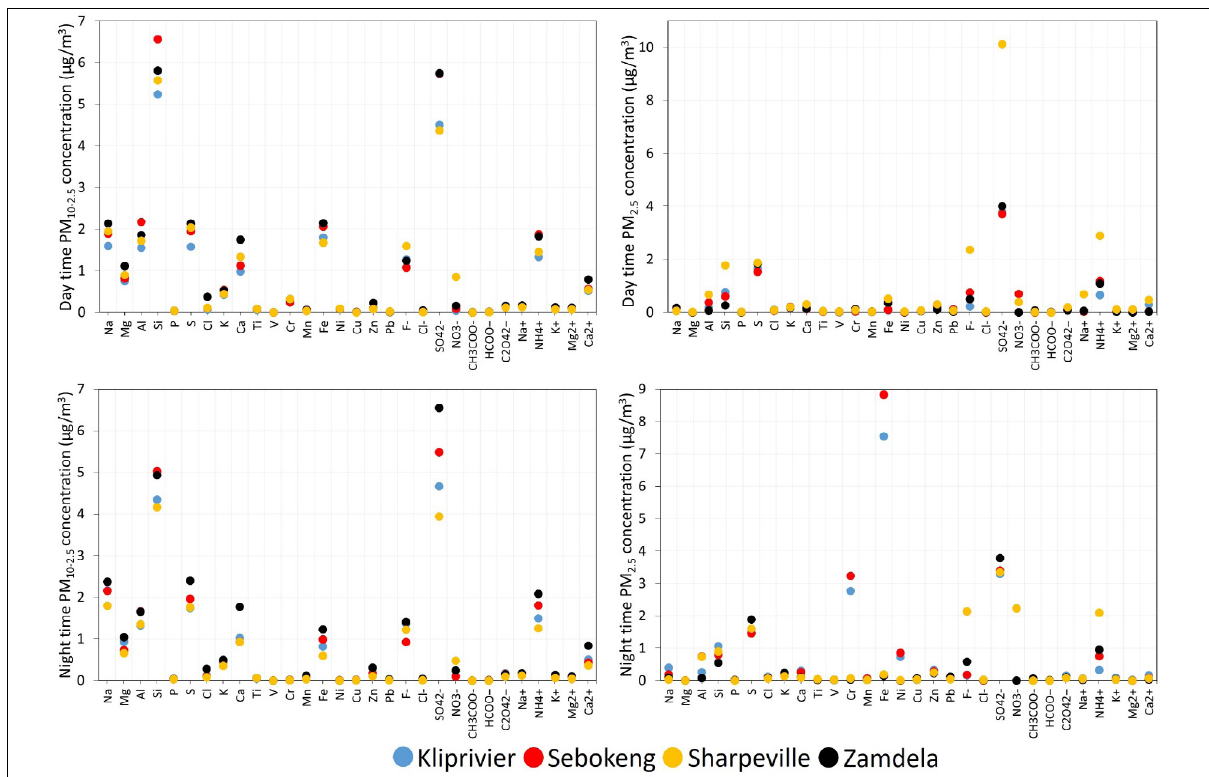
and PM at all the 10-2.5 2.5